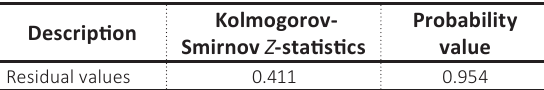
Table 2. Data normality test results